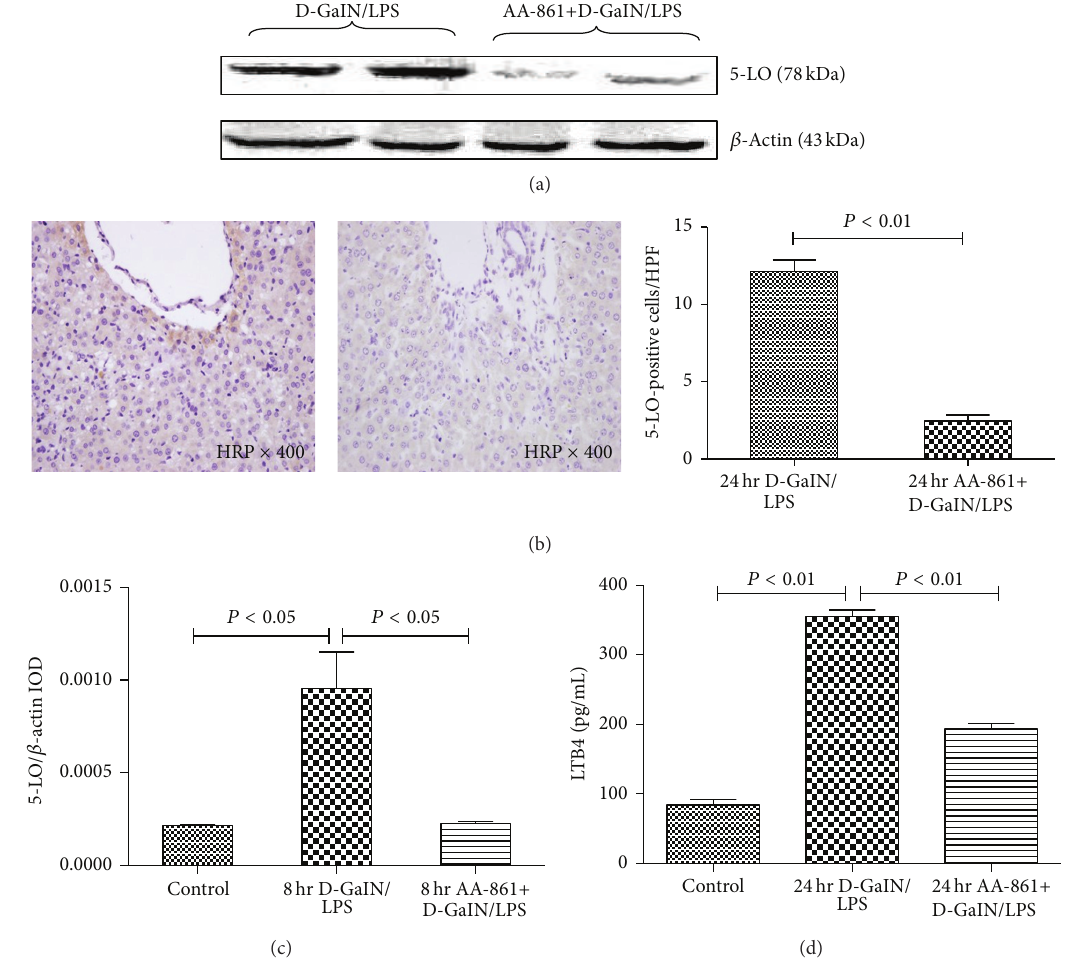
Figure 4: AA-861 significantly decreased total hepatic 5-LO protein and mRNA expression in D-GalN/LPS-treated animals. (a) Representative western blot analysis of the total 5-LO protein expression in liver samples 24 hr after D-GalN/LPS treatment in animals receiving placebo or AA-861. (b) AA-861 significantly abrogated the increased number of 5-LO-positive cells in the liver from D-GalN/LPS- treated rats. Representative photomicrographs (400x) of liver sections immunostained with 5-LO antibody 24 hr after D-GalN/LPS-treated rats received placebo (left panels) or AA-861 (right panels). (c) Representative RT-PCR analysis of 5-LO mRNA expression in liver samples 8 hr after D-GalN/LPS treatment in animals receiving placebo or AA-861. (d) AA-861 significantly reduced LTB4 levels in liver from D- GalN/LPS-treated rats. Liver tissue was obtained 24 hr after D-GalN/LPS treatment from animals receiving placebo or AA-861. Samples were homogenized and extracted in C18-silica, reverse-phase cartridges, and LTB4 was determined by highly specific enzyme immunoassay. Results represent the mean ± standard